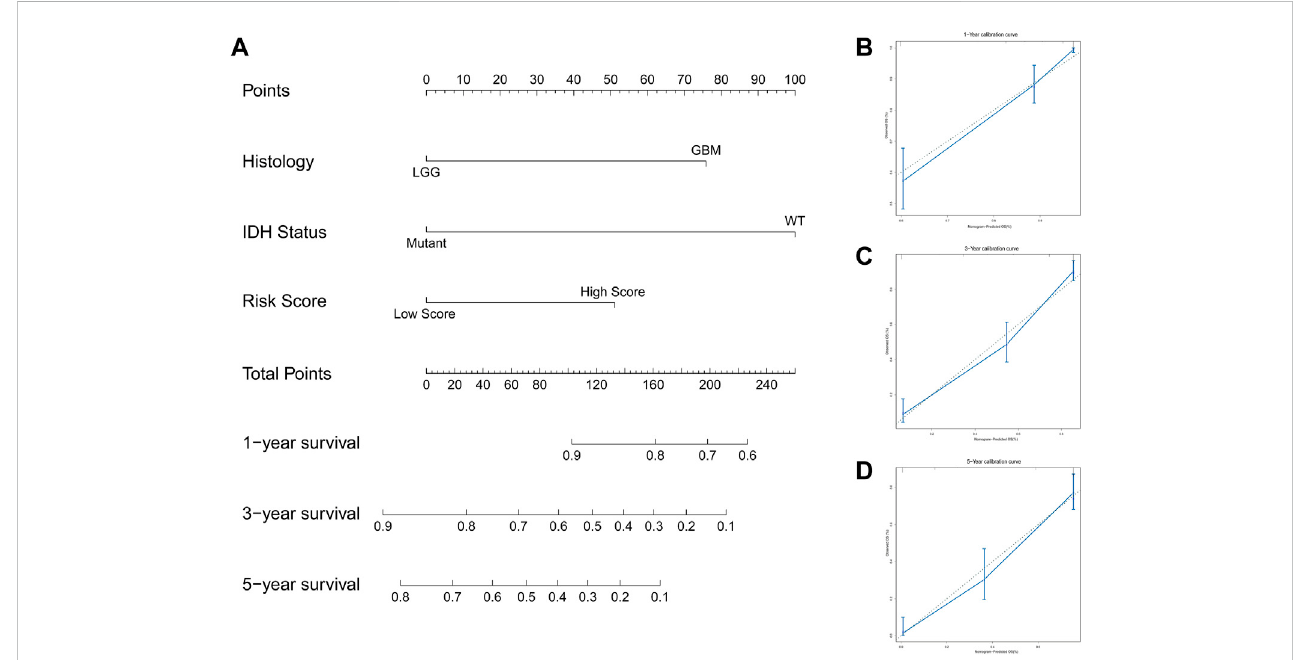
FIGURE 5 Constructed a nomogram based on the risk scoring model and independent clinical factors. (A) Nomogram predicts 1 -, 3 -, and 5-year OS for glioma patients. (B – D) Calibration curves for 1-, 3-, and 5-year